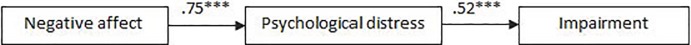
Empirically supported model of disruption to social/leisure activities during the week before completing a shift on the crisis line.